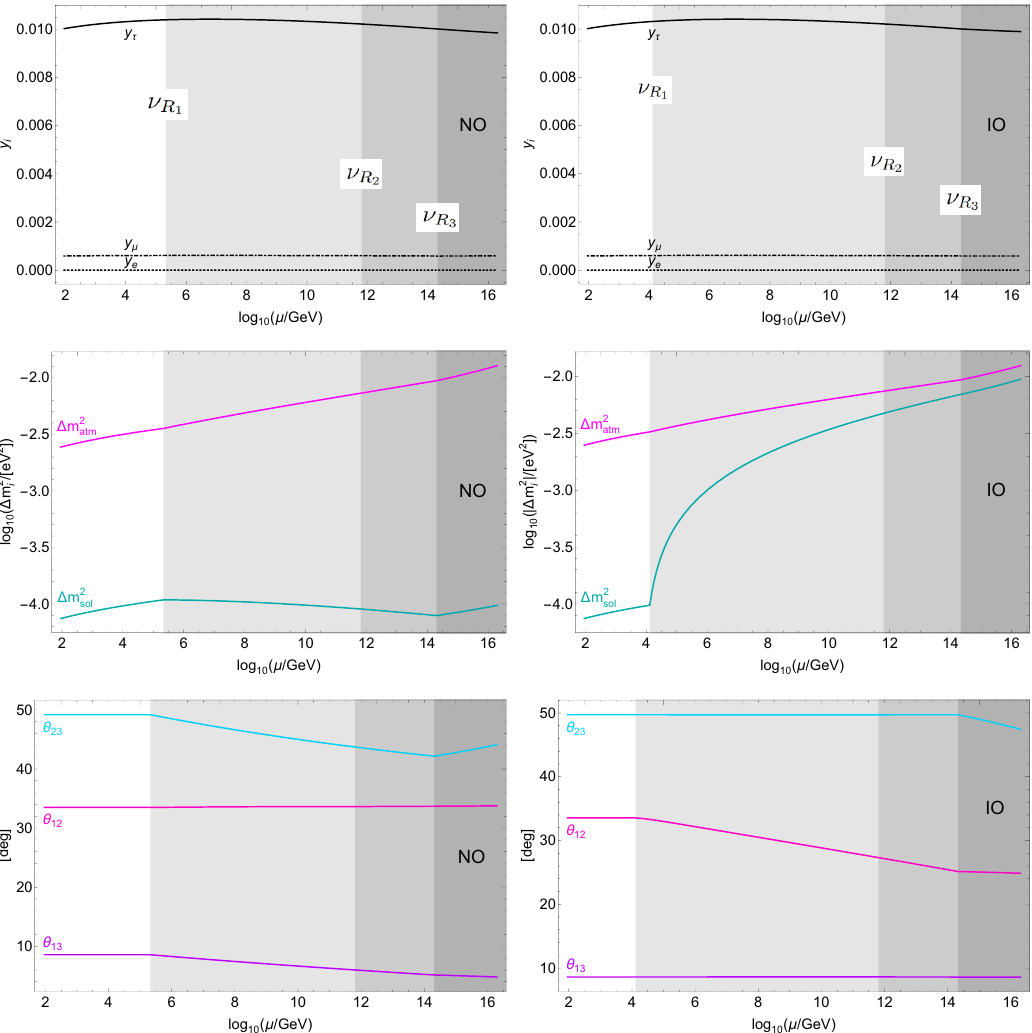
Figure 1 . Plots depicting the importance of the RGE running on the tau lepton mass and neutrino mass-squared as well as mixing parameters. Scales, where the heavy right-handed neutrinos ν R decouple from the theory, are presented via different shades of